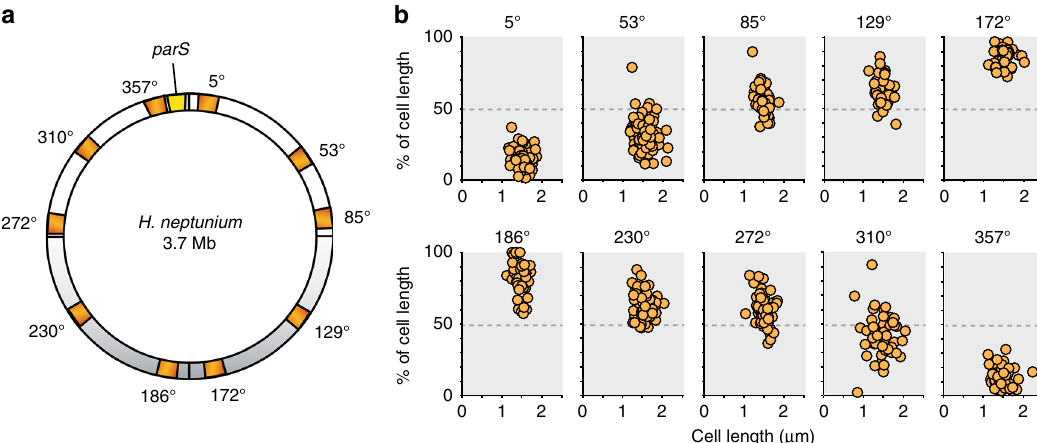
Fig. 7 Spatial arrangement of the H. neptunium chromosome. a Schematic showing the locations of chromosomal loci tagged with the Y. pestis ParB- parS pMT1 system. b Subcellular localization of ten different chromosomal loci distributed evenly across the P Zn - mCherry-parB pMT1 ) carrying parS pMT1 at the indicated chromosomal locations (AJ64-69, SRE13-15, AJ49) were grown in MB medium and analyzed by DIC and fl uorescence microscopy. The relative subcellular positions of the tagged loci (as re fl ected by the centers of mass of the respective foci) were determined in swarmer and early stalked G1-phase cells and plotted versus the total cell length, with 0% corresponding to the old ( fl agellated) pole and 100% to the new (future stalked) pole. n = 75 cells (5°), 118 cells (53°), 60 cells (85°), 48 cells (129°), 53 cells (172°), 50 cells (186°), 67 cells (230°), 64 cells (272°), 50 cells (310°), and 52 cells